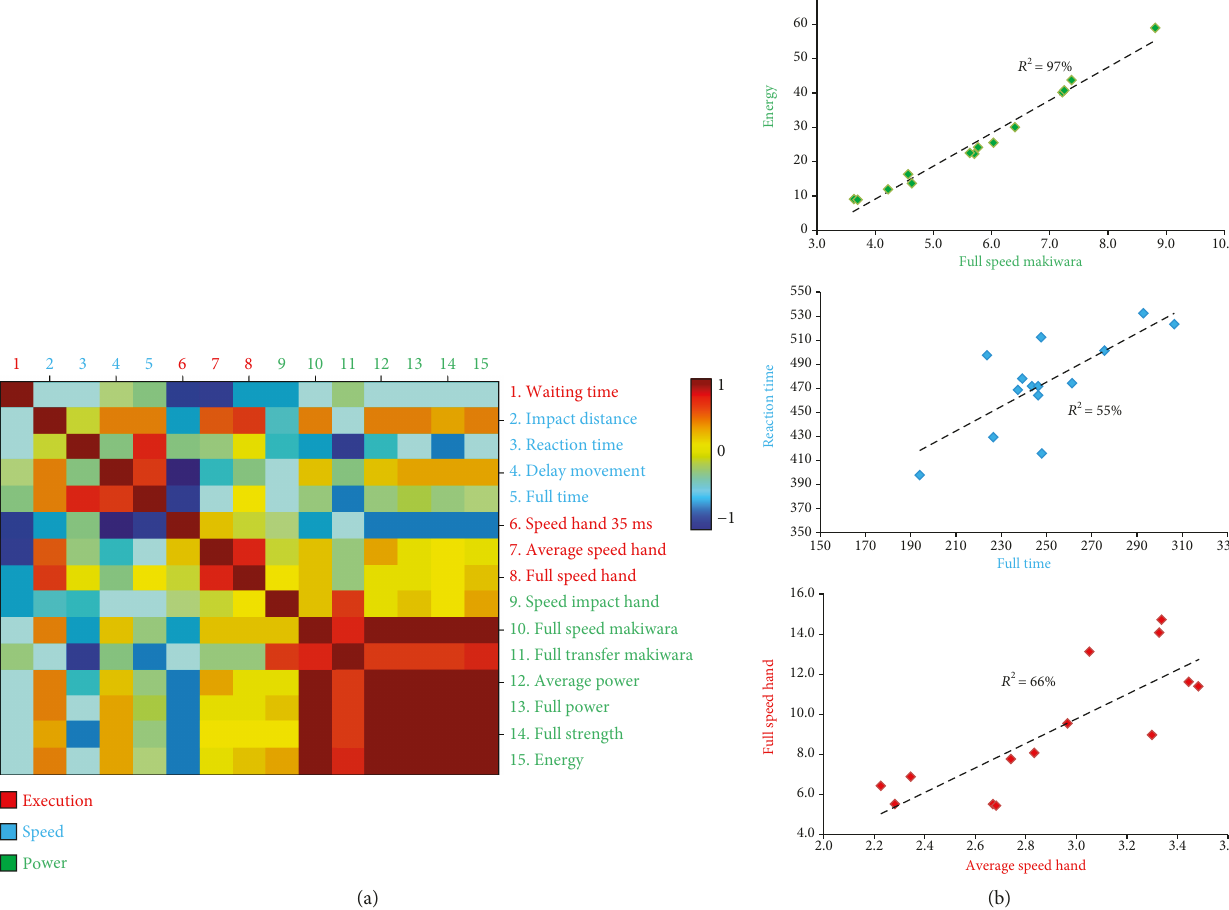
Figure 3: Statistical relationships involving motor performance measures. (a) Results of principal component analysis (PCA) showed in the form of a correlation matrix. The 82.86% of the total variance was explained by 3 latent variables de fi ned as Power (green), Speed (blue), and Execution (red). (b) Scatter plots of the most correlated motor performance measures for the Power ( R 2 = 0 97 ), Speed ( R 2 = 0 55 ), and Execution ( R 2 = 0 66 ) principal